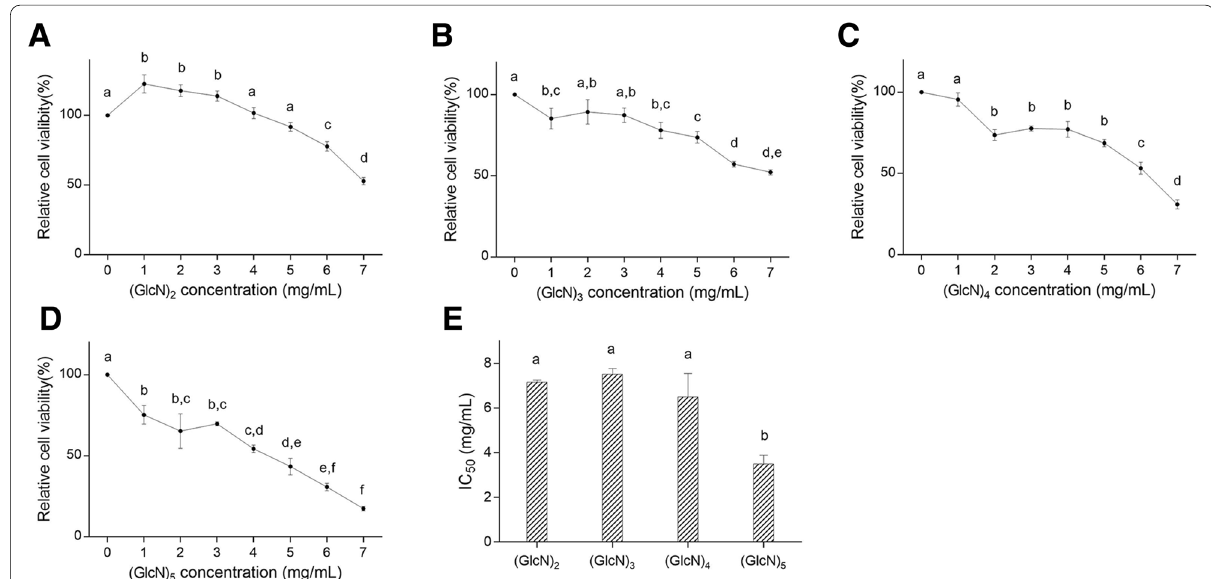
Fig. 2 COS (DP 2–5) inhibited Cell viability in HepG2 cells. A (GlcN) 2 . B (GlcN) 3 . C (GlcN) 4 . D (GlcN) 5 . E IC 50 values. Cells were treated with or without different concentration (0–7 mg/mL) of COS for 48 h. Data were represented as